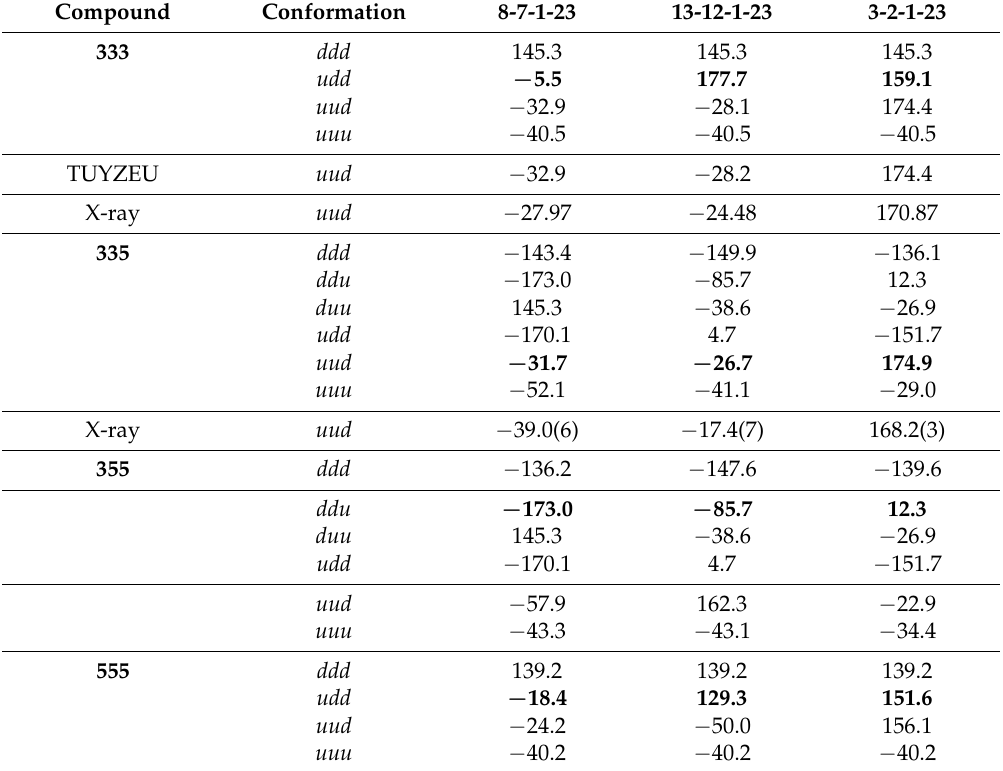
Table 6. Torsions ( ◦ ). The minimum energy conformation in black; the crystallographic structure, TUYZEU, in italics.